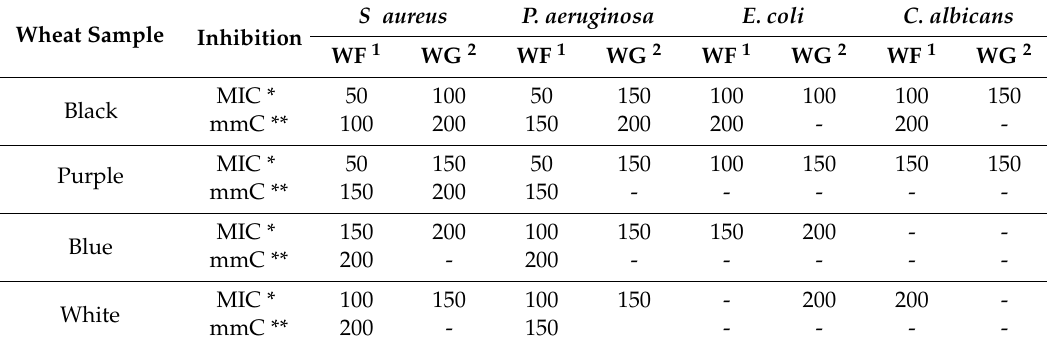
Table 3. Minimum inhibitory concentration (MIC) and minimum microbicidal concentration (MMC) of colored wheat anthocyanin extracts in mg / mL against human pathogens. S Wheat Sample Inhibition